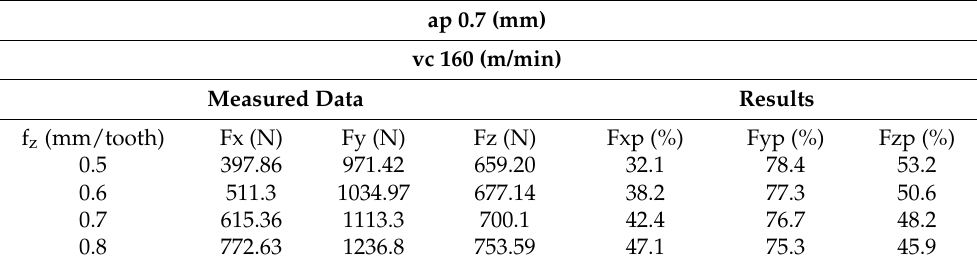
Table 10. Results for ap = 0.7 mm and vc = 160 m/min.